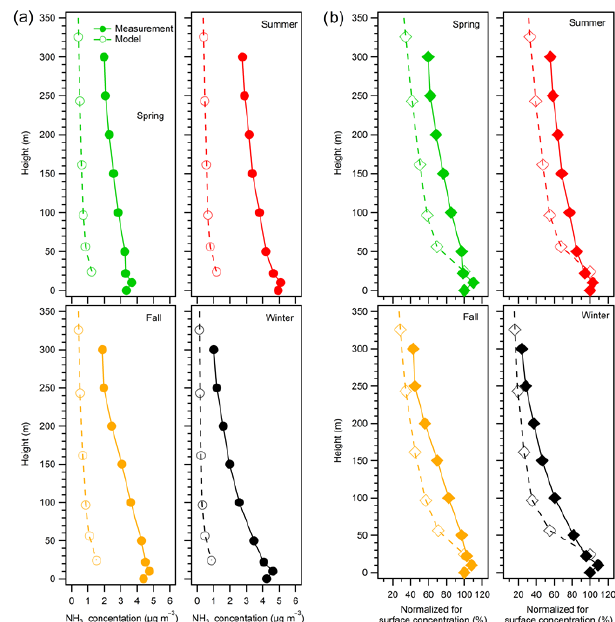
Figure 9. (a) Comparison of seasonal 2012 NH 3 concentrations (µgm − 3 ) : passive measurements (solid lines) and 2011 CAMx modeling results (dashed lines); (b) comparison of seasonal NH 3 passive measurements normalized by surface concentrations (solid lines) and CAMx modeling results (dashed lines). Each profile is normalized such that the concentration at the lowest level is set to